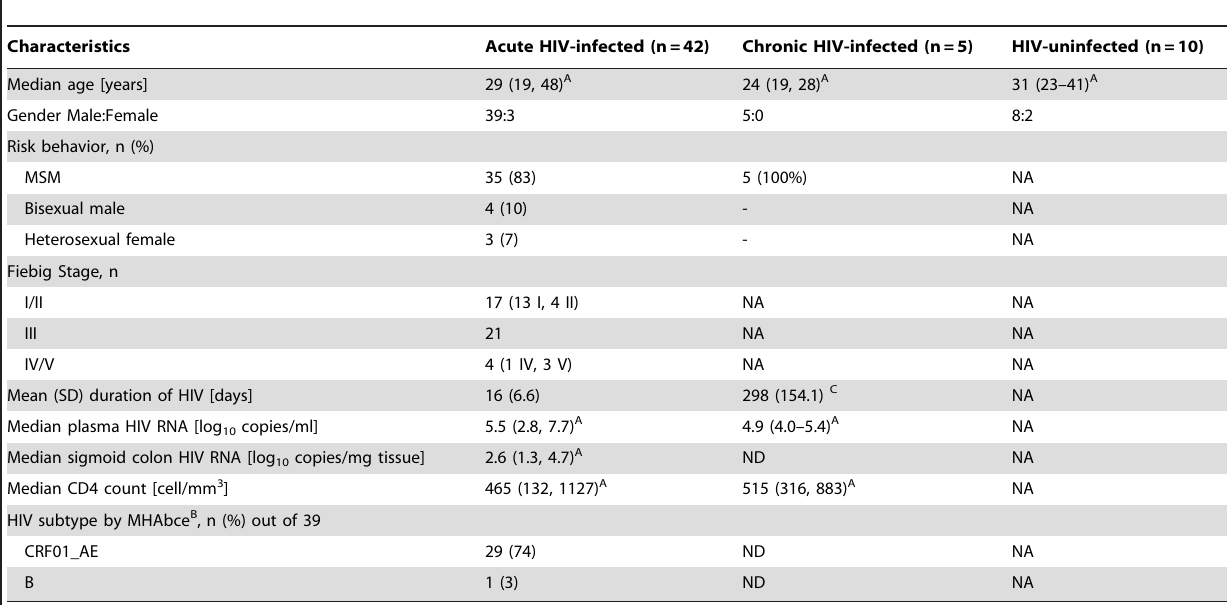
Table 1. Clinical, immunological and virological baseline characteristics and demographics of study